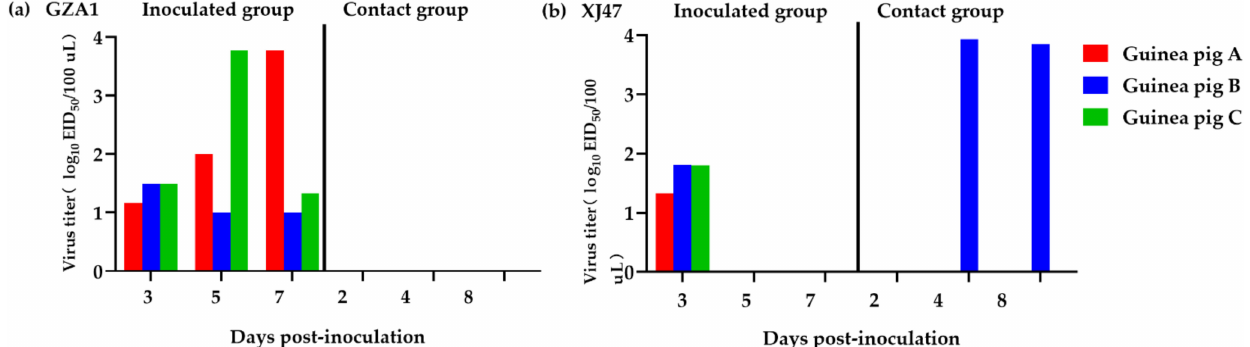
Figure 3. Virus titers of guinea pig nasal washes after infection with the GZA1 and XJ47 strains: ( a ) virus shedding of guinea pig after infection with the GZA1 strain; ( b ) virus shedding of guinea pig after infection with the XJ47